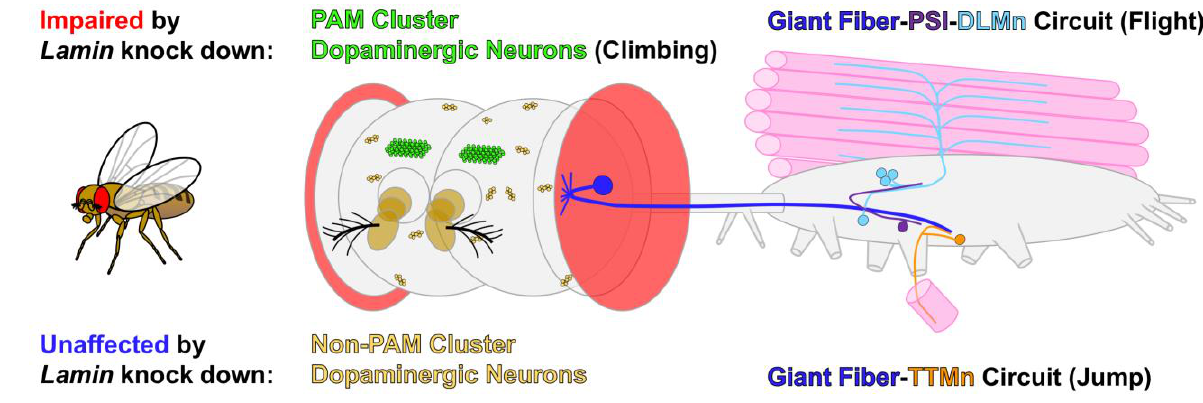
FIGURE 1: Specific neurons and neural circuits in Drosophila are more sensitive to reduction of Lamin levels. Schematic diagram of the adult fly central nervous system (brain and thoracicoabdominal ganglion) highlighting the neurons and neural circuits that were studied in Oyston et al . 2018. Eyes, antennae and certain muscles are also depicted as landmarks. For simplicity, only one side of the bilateral giant fiber system is shown here. Flies with decreased neuronal Lamin expression exhibited age-dependent motor deficits and shortened life span. The authors observed histological or functional defects in PAM (protocerebral anterior medial) cluster dopaminergic neurons and in escape response mediating neuronal circuits composed of giant fiber neurons, peripherally synapsing interneurons (PSI) and dorsal longitu- dinal motor neurons (DLMn). In contrast, non-PAM cluster dopaminergic neurons and a parallel giant fiber circuit comprised of tergo- trochanteral motor neurons (TTMn) were not